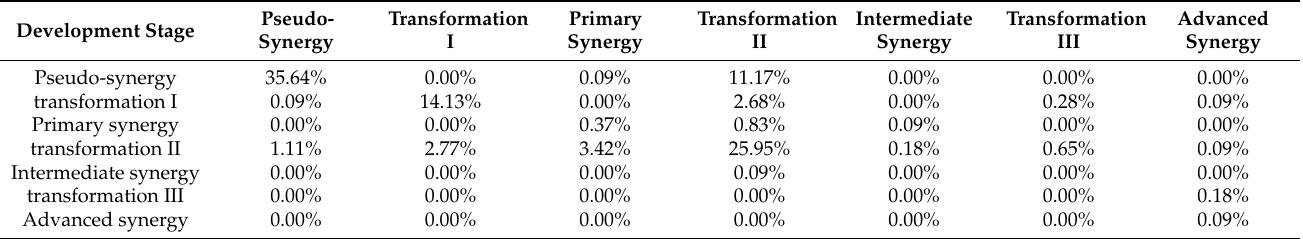
Table 3. Markov transition probability matrix of GEP–GDP synergy states in the Chinese mainland during the investigation